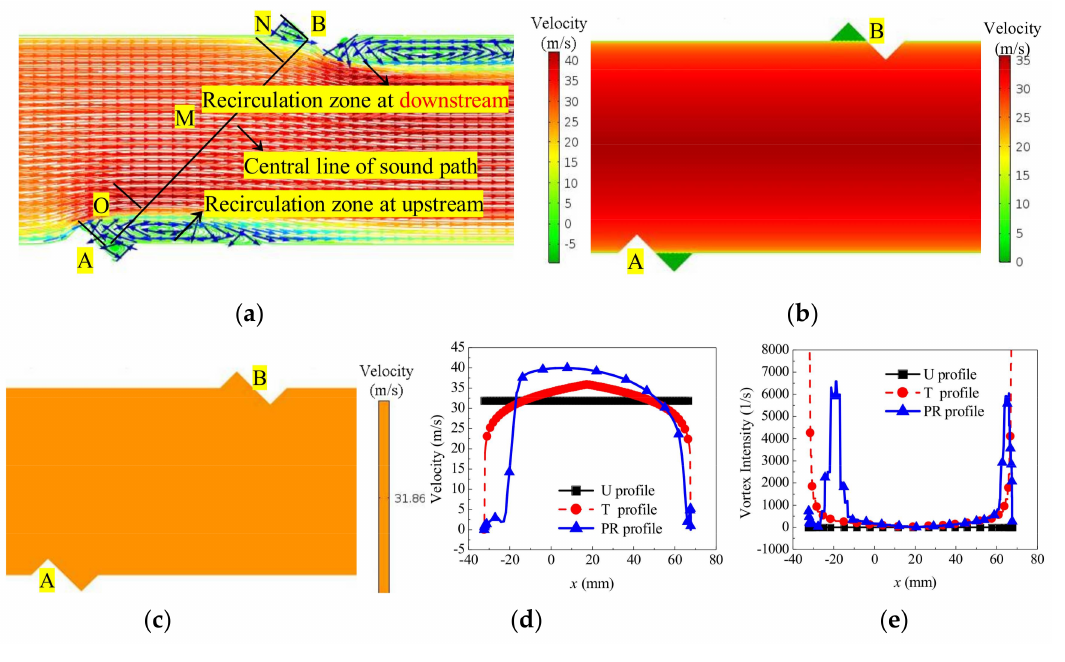
Figure 4. Background flow field inside the sensor ( v = 31.86 m/s). ( a ) Velocity of the PR profile. ( b ) Velocity of the T profile. ( c ) Velocity of the U profile. ( d ) Velocity on the central line of the sound path. ( e ) Vortex intensity on the central line of the sound